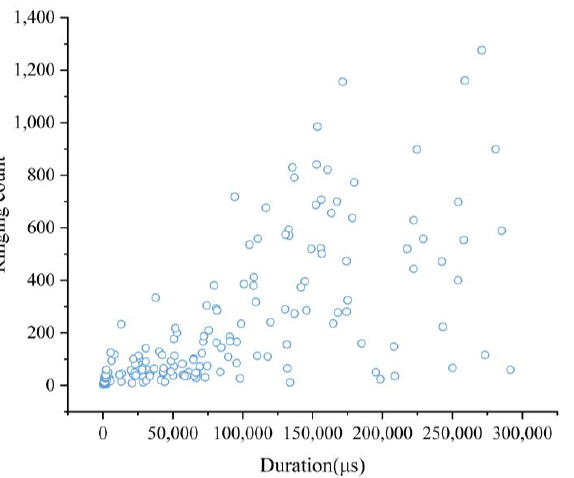
12 of 26 Figure 10. Impact-amplitude correlation diagram of cable noise signal of Caihong Bridge. 2.